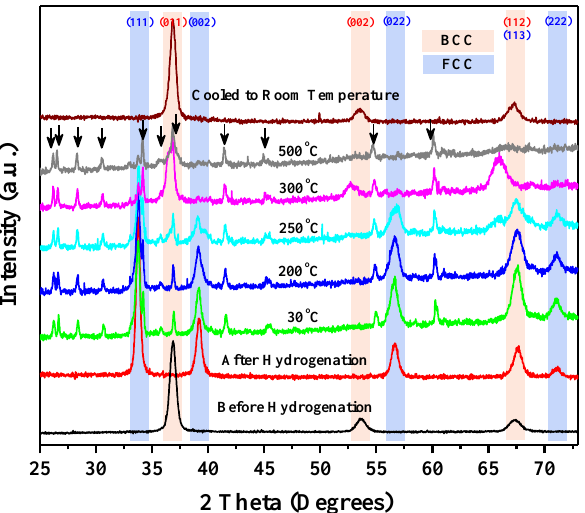
Figure 3. (Color online) The in situ heating XRD patterns of the TiZrHfMoNb hydride powder collected at temperatures from RT to 500 °C and the XRD pattern acquired after the sample was cooled down to RT.